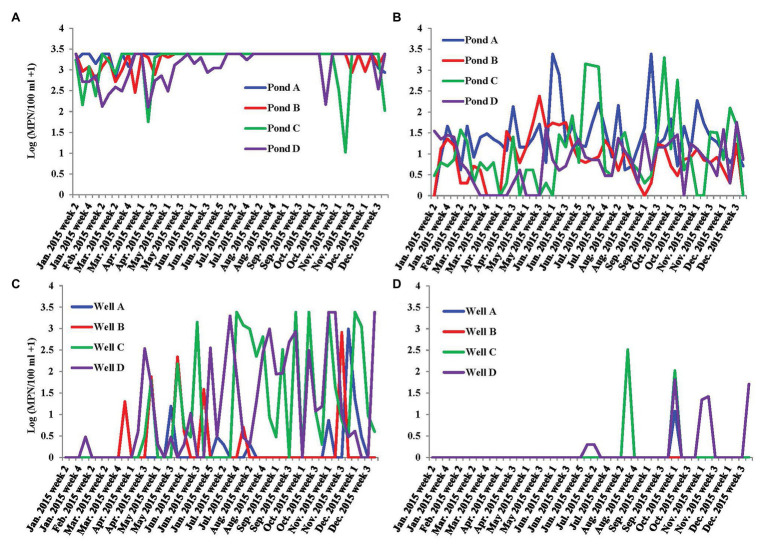
Dynamics of fecal indicators, coliform and generic E. coli, in the irrigation water of farms A–D on the ESV. (A) Most possible number (MPN) values of coliform in four tested irrigation ponds on ESV in 2015; (B) MPN values of generic E. coli in four tested irrigation ponds on ESV in 2015; and (C) MPN values of coliform in four tested irrigation wells on ESV in 2015; and (D) MPN values of generic E. coli in four tested irrigation wells on ESV in 2015.